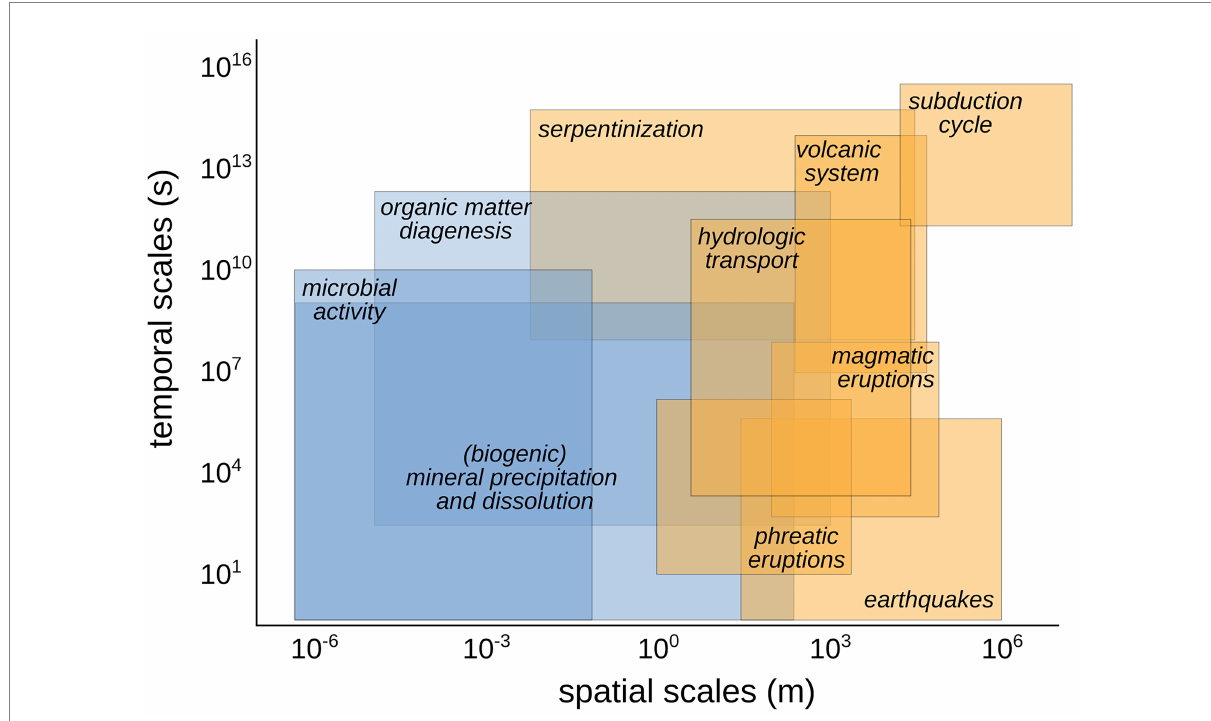
FIGURE 2 Conceptual diagram showing the relative spatial and temporal scales of biological (in blue) and geological (in orange) processes at convergent margins and their overlap in space–time. Similar conceptual diagram showing the overlap between geological and biological processes in different tectonic settings can help to identify the relevant processes to track and the type of synoptic, co-located samples to